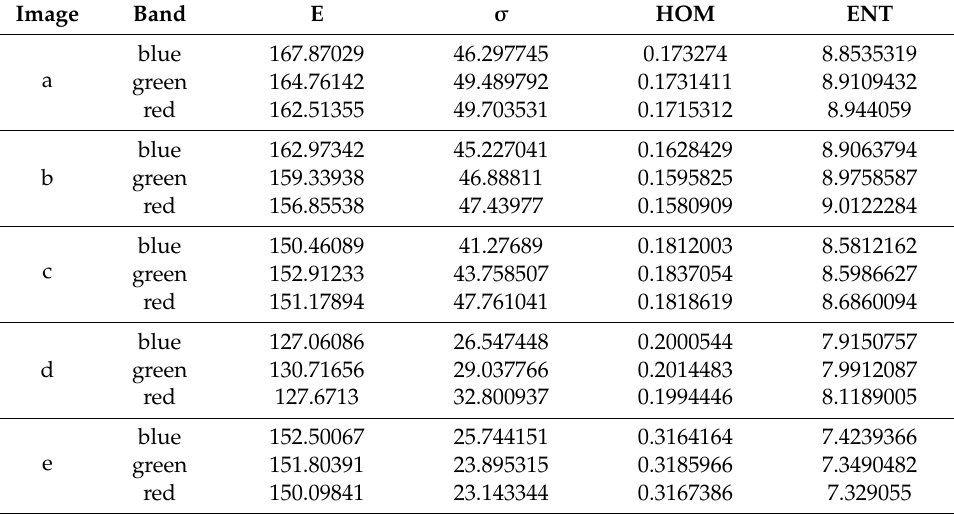
Table 1. Statistics of gray level features and texture